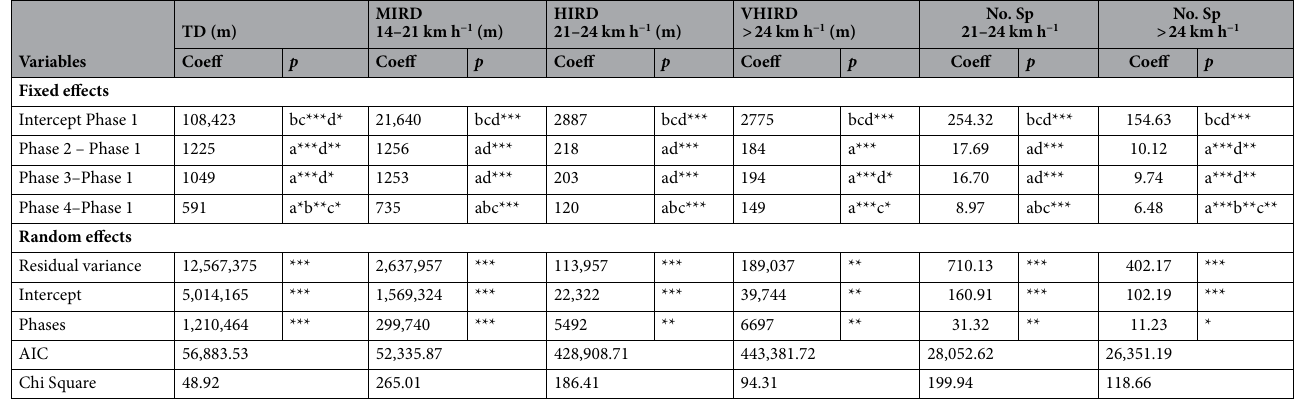
Table 2. Linear mixed model results of match movement profiles by season phases for Spanish soccer teams. * p < 0.05, ** p < 0.01, *** p < 0.001—comparing the six models in the different phases of the season, m meters, No. number, TD total distance, MIRD medium-intensity running distance, HIRD high-intensity running distance, VHIRD very high-intensity running distance, Sp21-24 Sprints between 21 and 24 km h −1 , Sp > 24 = Sprints at speeds above 24 km h −1 , Coeff. Coefficient, a = differences with Phase 1; b = differences with Phase 2; c = differences with Phase 3; d = differences with Phase